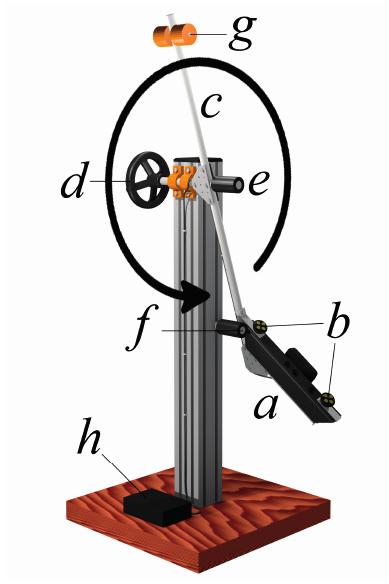
Figure 1. The equipment developed for SkanLab. ( a ) Sensor unit; ( b ) visible light LED sources; ( c ) rotating detection frame; ( d ) manual drive wheel; ( e ) handle; ( f ) frame stop; ( g ) rod and balance weights; ( h ) mains and computer